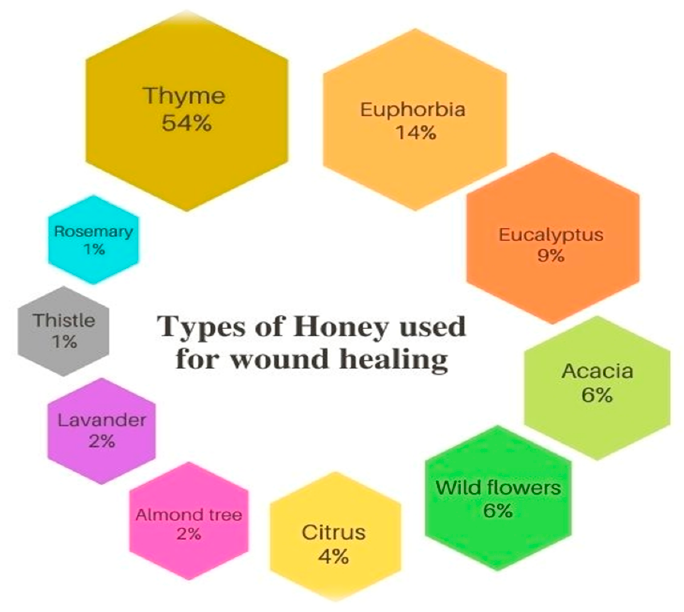
Figure 2. Honey used for wound healing.